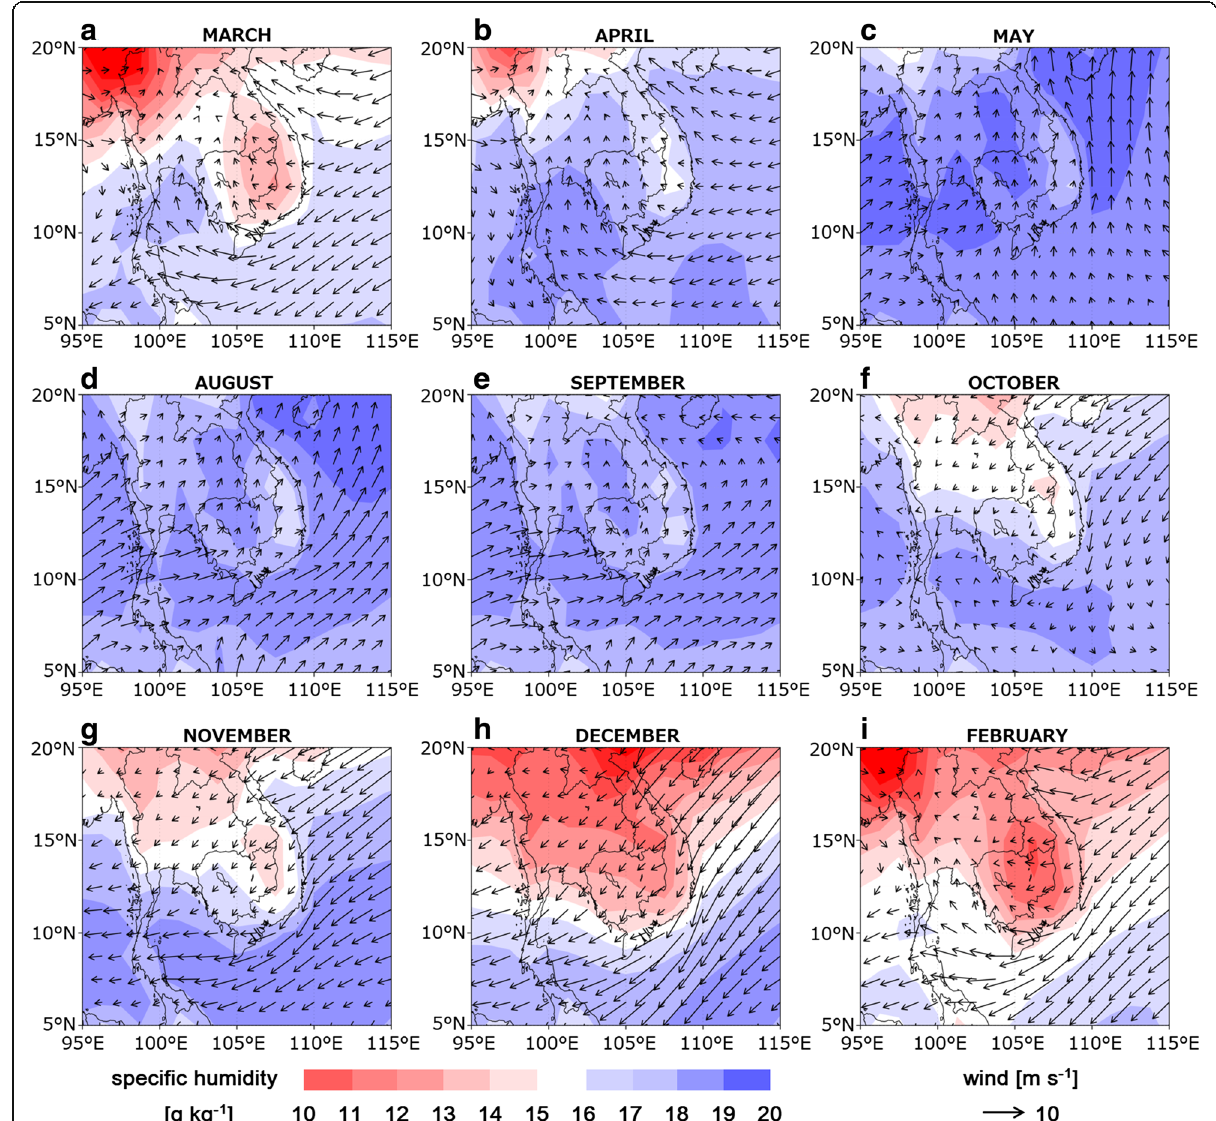
Fig. 3 Wind and specific humidity at 1000 hPa over the Indochina Peninsula. Monthly-mean data for March ( a ), April ( b ), May ( c ), August ( d ), September ( e ), October ( f ), November ( g ), December ( h ), and February ( i ) as 6-year (2010 – 2015) averages are shown. Data are from JRA-55 historical